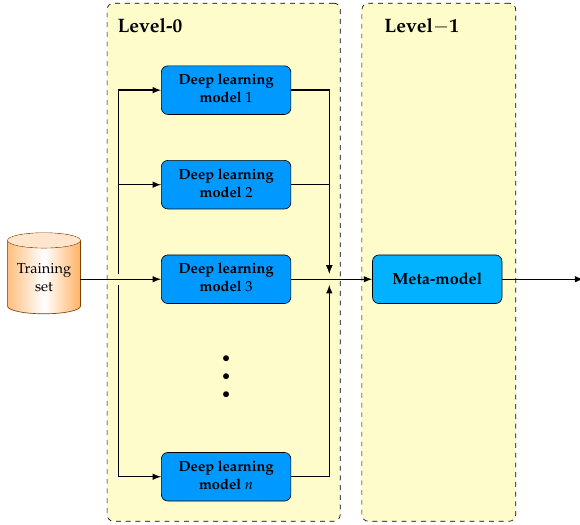
Figure 3. Stacking ensemble of deep learning